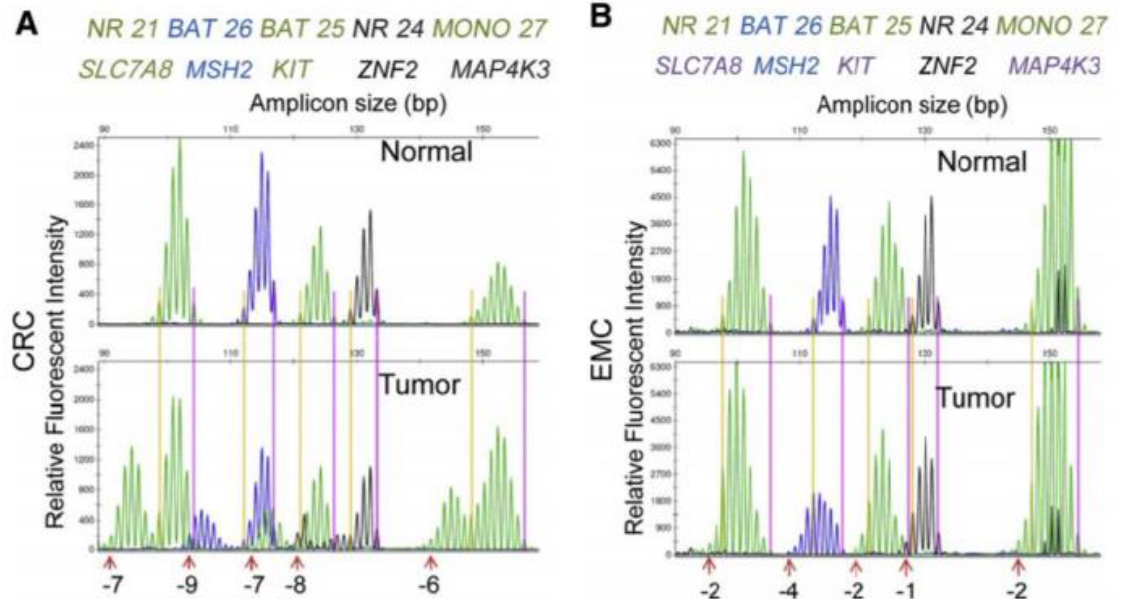
Figure 3. Differences in microsatellite instability (MSI) profiles between CRC and EMC [12] . Legend: MSI: microsatellite instability; CRC: colorectal cancer; EC: endometrioid cancer. ( A ): MSI profile of a representative MSI high (MSI-H) CRC with its paired normal control. Shifts in microsatellite repeat lengths are labeled at the bottom (e.g., gene NR21/SLC7A8 , −7 nt). ( B ): MSI profile of a representative MSI-H EMC compared with its paired normal control. Shifts in microsatellite repeat lengths are labeled at the bottom (e.g., gene NR21/SLC7A8 , −2 nt).